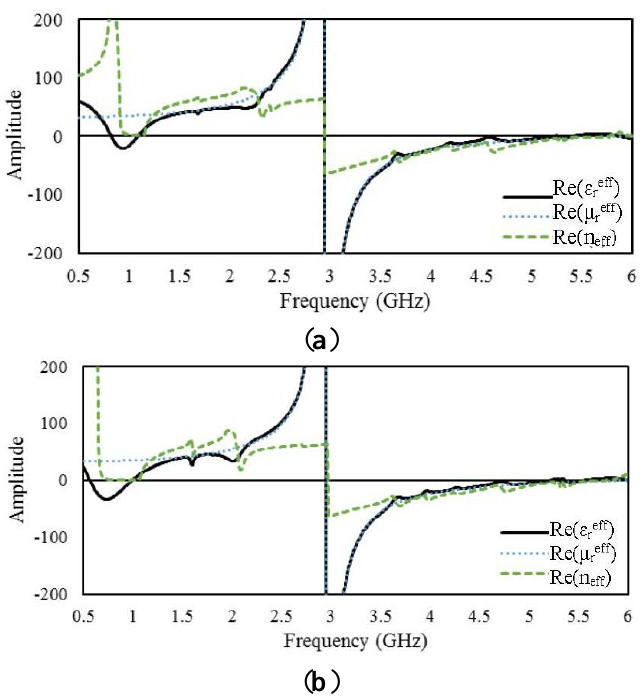
Figure 12. Real parts of the effective parameters of 2 × 2 arrays of unit cell D: ( a ) open array and ( b ) interconnected